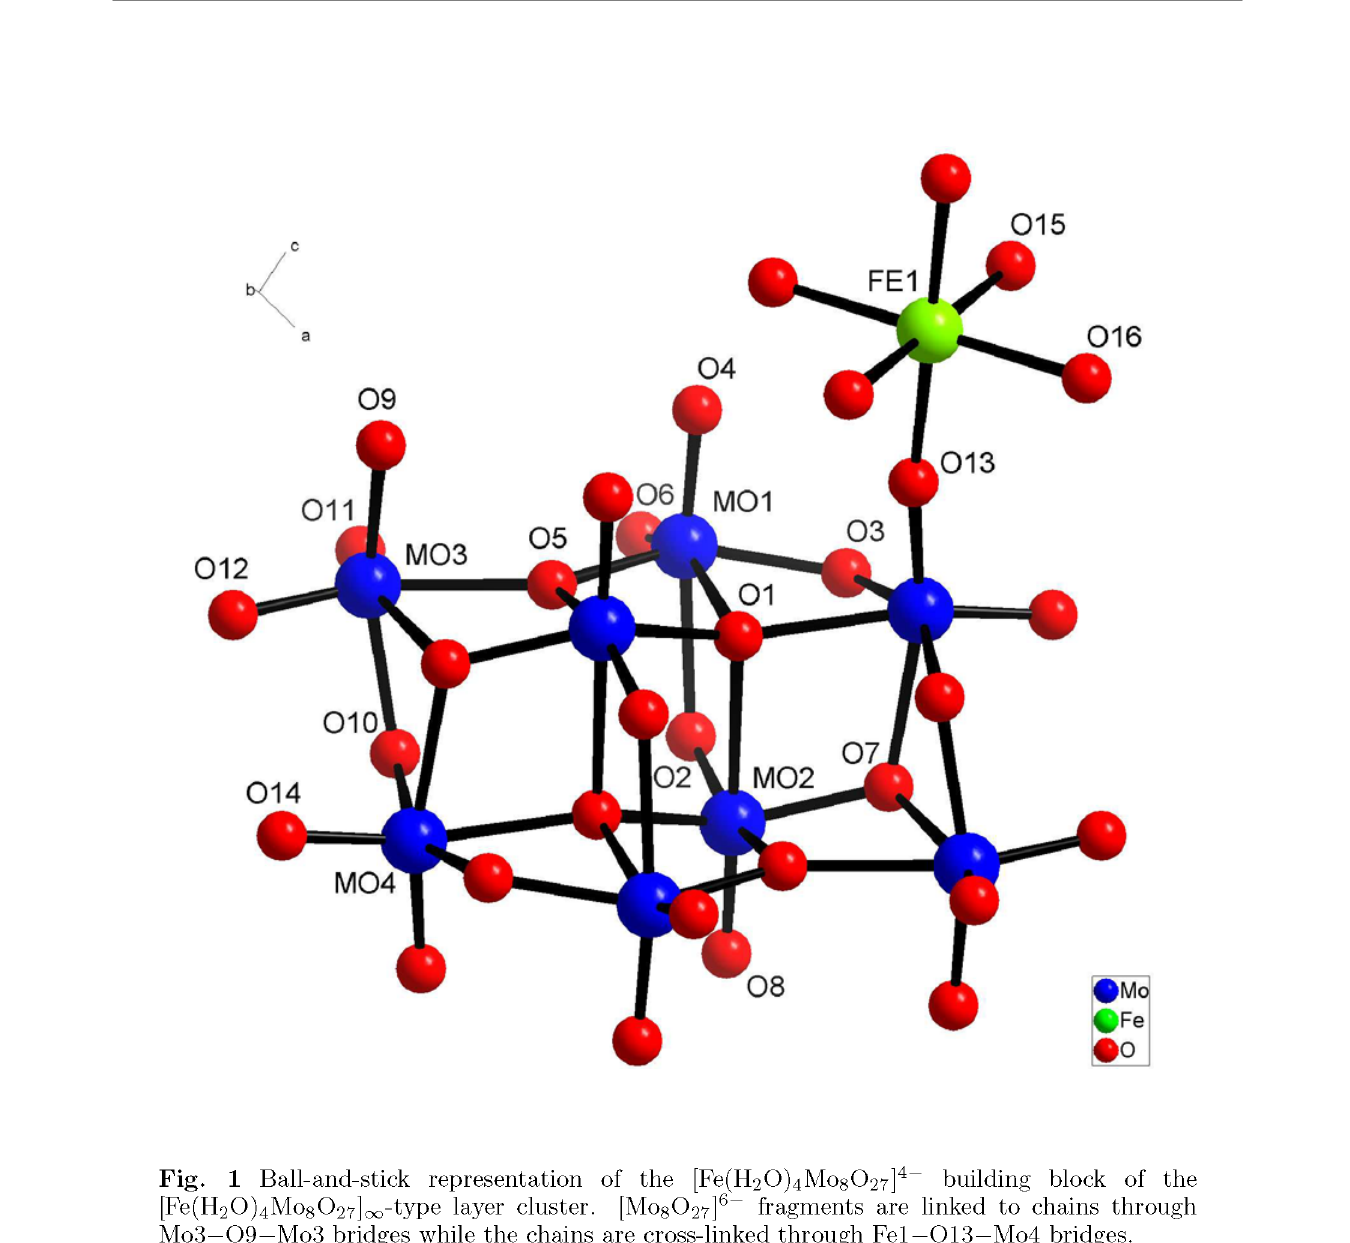
Fig. 1 Ball-and-stick representation of the [Fe(H20)4MosO27] 4 building block of the [Fe{H20/4MosO27]c~-type layer cluster. [Mo8027] 6 fragments are linked to chains through Mo3-O9-Mo3 bridges while the chains are cross-linked through Fel-O13-Mo4